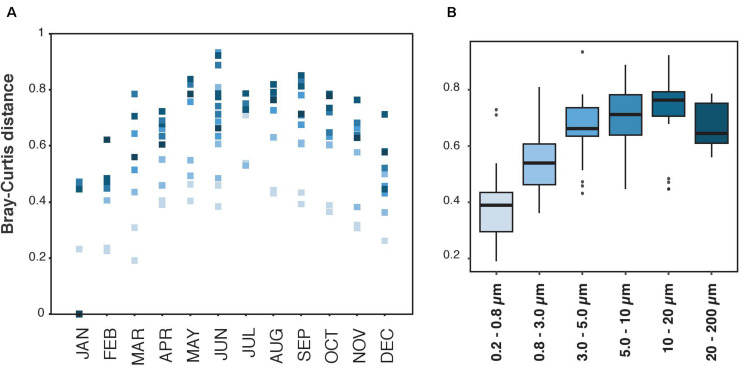
Bray-Curtis distances measured between January 2013 and the other months, and for each size-fraction separately. (A) Representation of Bray-Curtis values along time, from January to December. The dots are colored by size-fraction as they are in panel (B). (B) Representation of Bray-Curtis values of each size-fraction. The upper and lower lines of each box-plot correspond to the 1st and 3rd quartile of the distribution of values. The median values are shown with horizontal black wide lines.